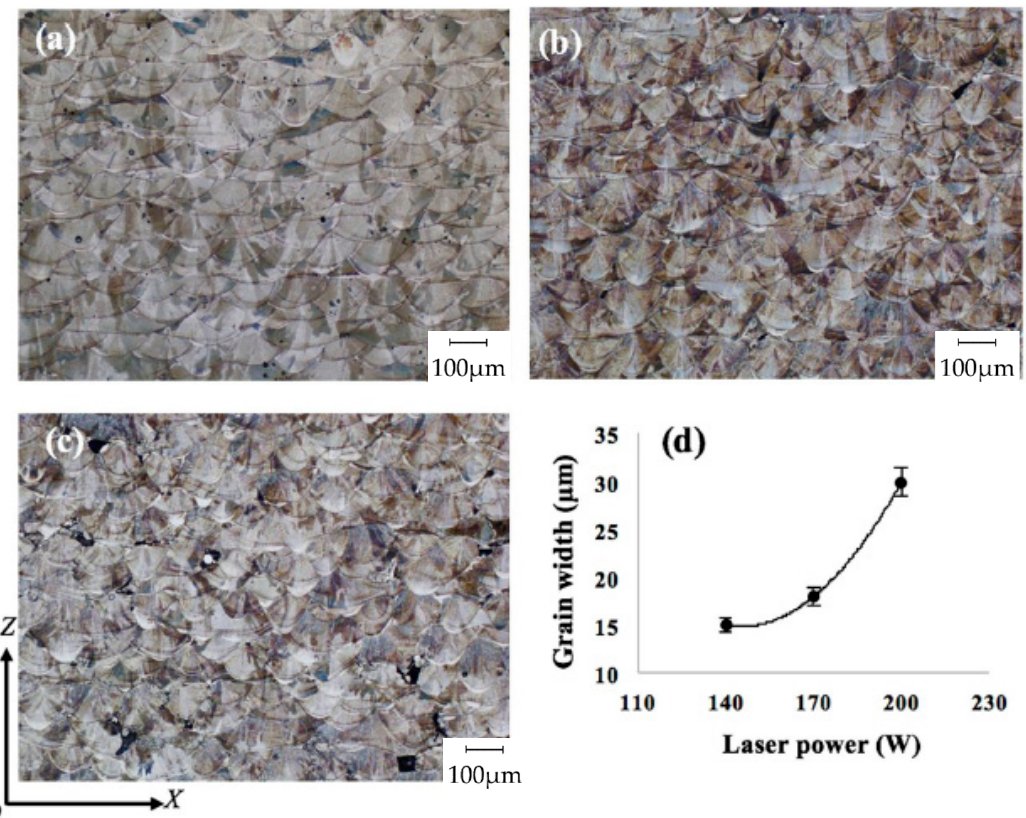
Figure 10. OM micrographs of L-PBF 316L microstructure produced at different laser powers, ( a ) 200 W; ( b ) 170 W; ( c ) 140 W; ( d ) grain width correlation to laser power values. Z specifies the building direction [134].